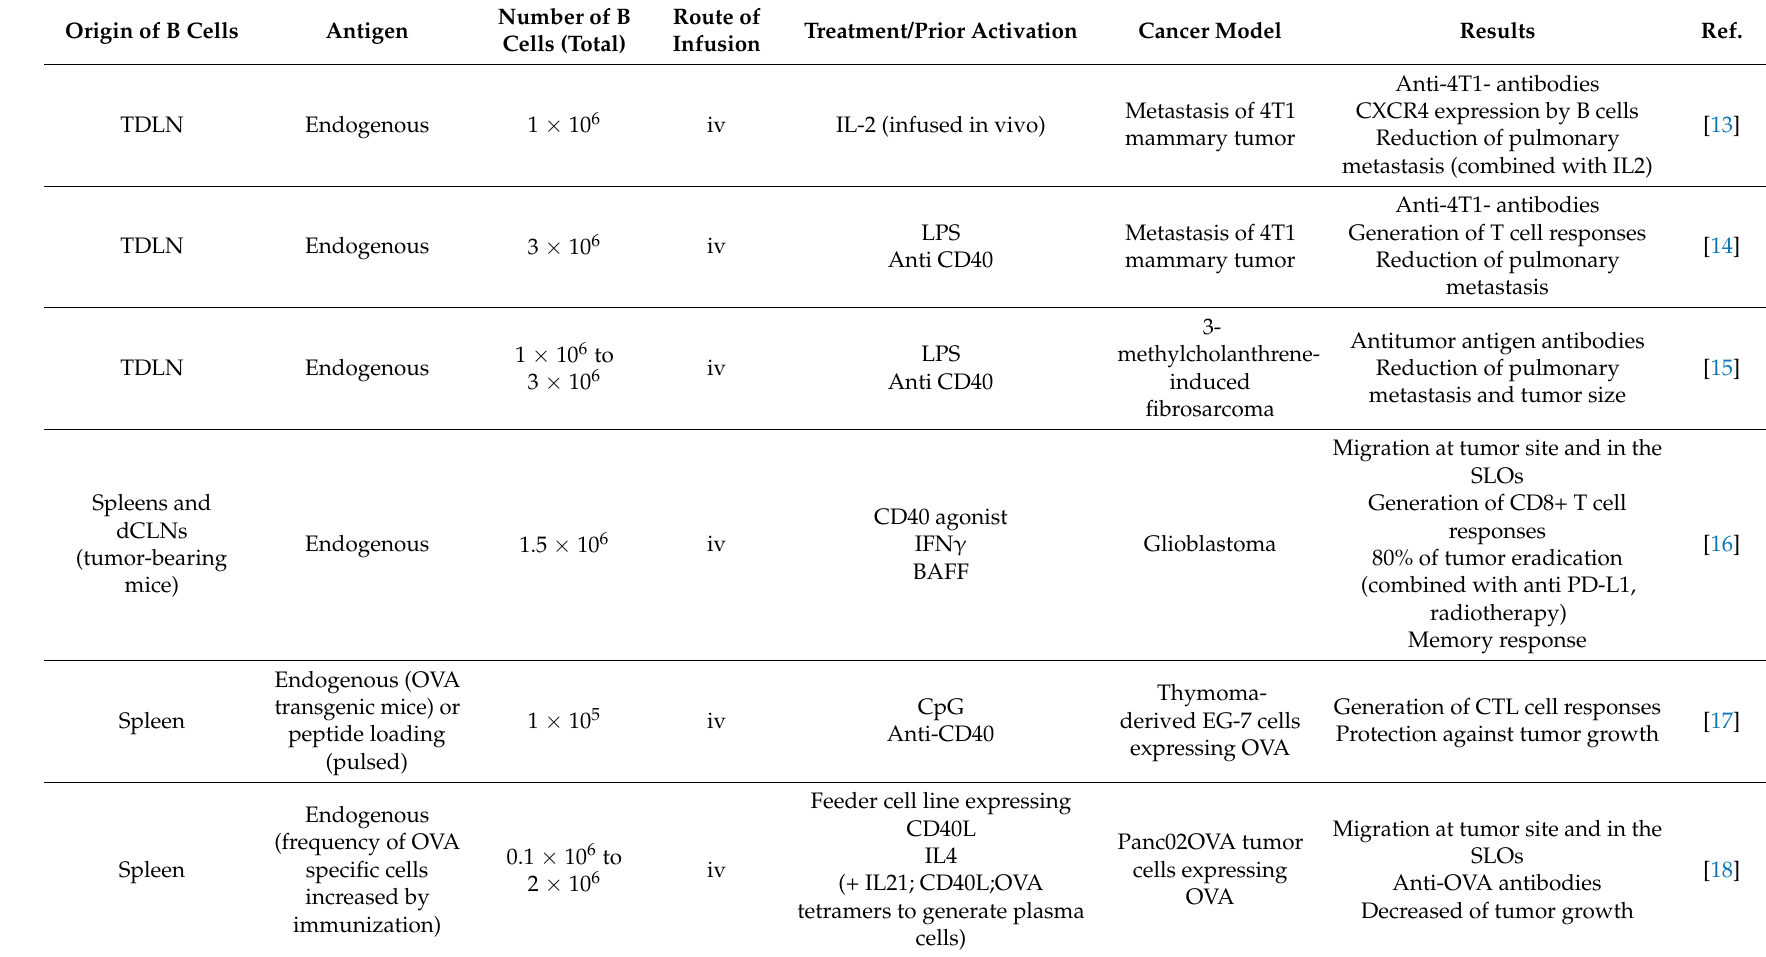
Table 1. Preclinical mouse studies of B cell transfer with endogenous or compelled tumor antigen presentation for cancer